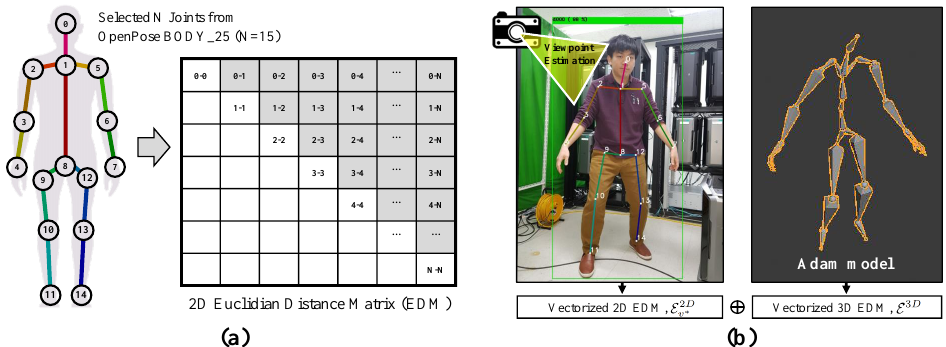
Figure 4. Skeletal representation: ( a ) skeletal representations derived from [6,7]; and ( b ) example of skeleton-based features. The vectorized EDMs were concatenated to form an action descriptor. Note that 2D EDM is highly affected by the camera